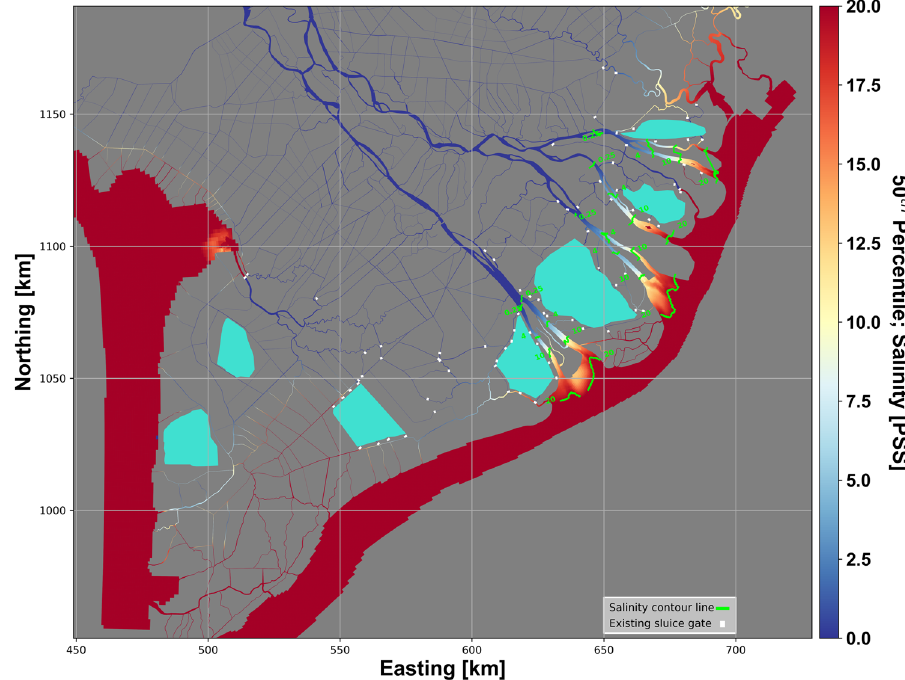
Fig. 5 Mekong Delta Salinity map, a moderate year in the existing conditions. Present-day spatial variation of salinity intrusion in the Mekong Delta estuarine and irrigation